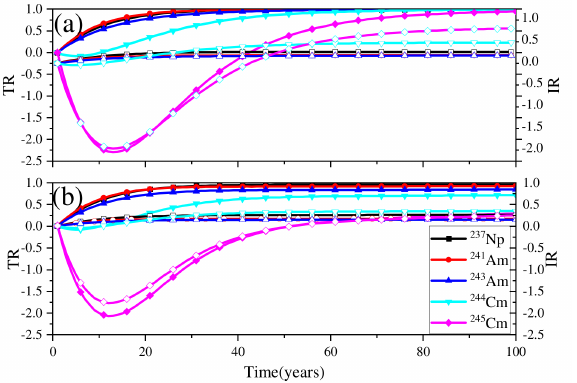
Figure 11. Evolution of TR (solid dot lines) and IR (empty dot lines) for scenario 1 ( a ) and scenario 2 ( b ).